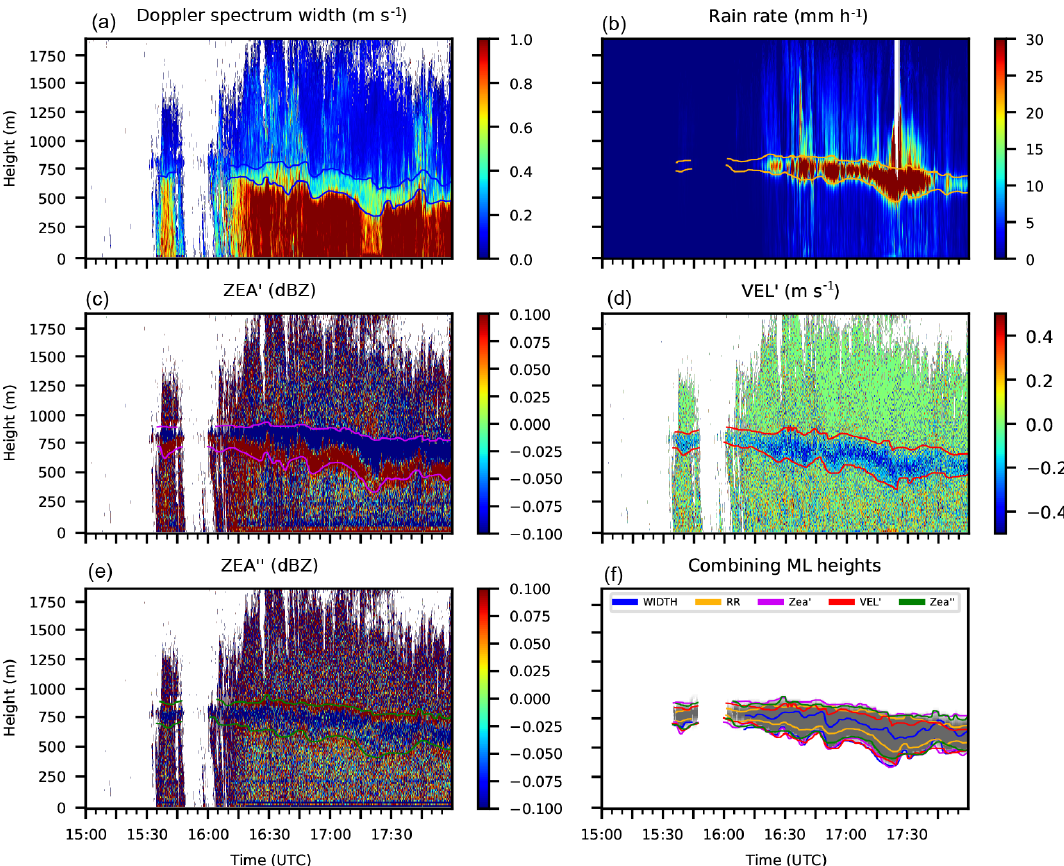
Figure 1. Determining the “true” melting layer (ML) for Hamburg on 8 March 2018 from 15:00 to 18:00UTC. Shown are the WIDTH, RR, ZEA (cid:48) , VEL (cid:48) , ZEA (cid:48)(cid:48) , and the “true” ML. The manually determined ML heights from each variable are shown using colored lines: blue lines represent WIDTH, orange lines represent RR, purple lines represent ZEA (cid:48) , red lines represent VEL (cid:48) , and green lines represent ZEA (cid:48)(cid:48) . The resulting “true” ML is shown in panel (f) using gray shading (see